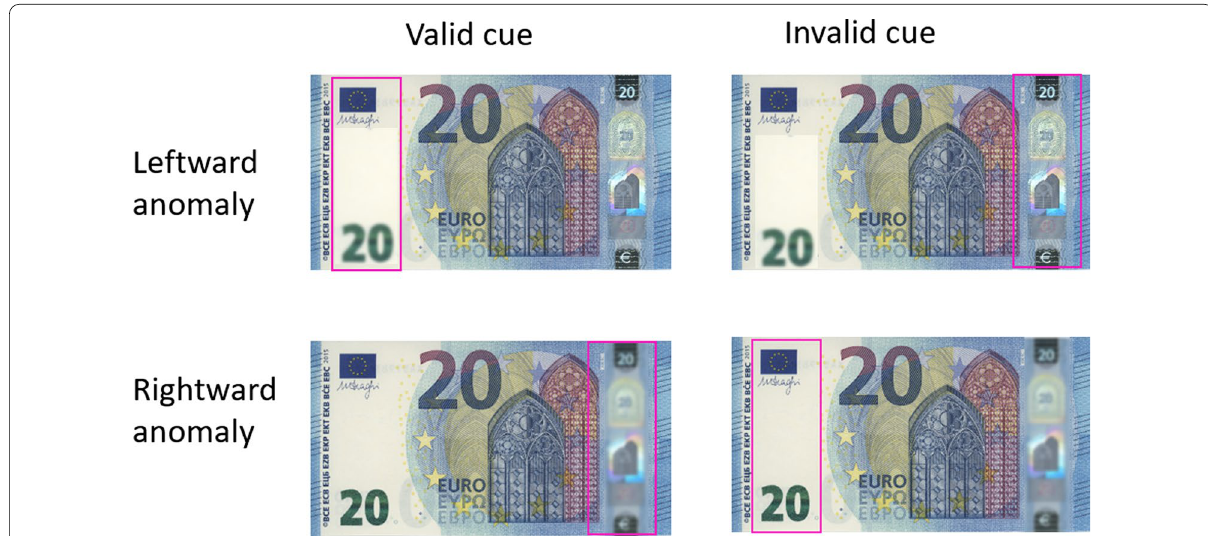
Fig. 2 Examples of manipulated banknotes that are part of the test set. The banknotes on top contain a counterfeited emerald number: top-left with a pink cue around the counterfeited emerald number; top-right with the pink cue around a genuine hologram. At the bottom, banknotes with a counterfeited hologram: left-bottom a pink cue around the counterfeited hologram; right-bottom with a cue around a genuine emerald number. The two banknotes on the left are validly cued (the cue is located near the feature that is counterfeited). The two banknotes on the right are invalidly cued: the cue is near a genuine feature, while the counterfeited feature is at the other